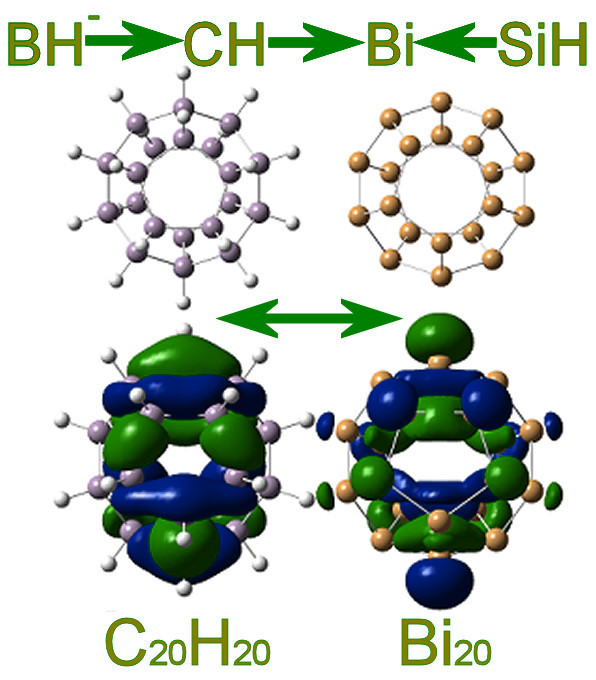
Illustration of the Bi/C fullerenes analogy. Comparison and analogy in geometrical and electronic structure of C20H20 and Bi20 fullerenes.